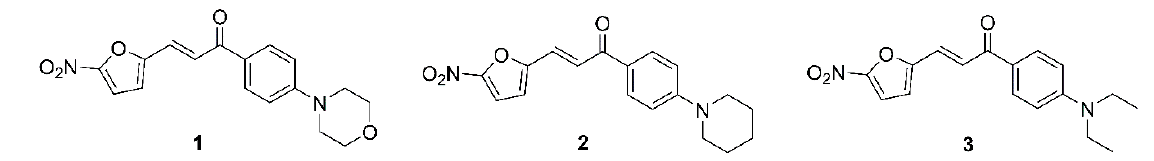
Figure 1. Structures of ( E )-3-(5-nitrofuran-2-yl)-1-(4-substituted-phenyl)prop-2-en-1-one